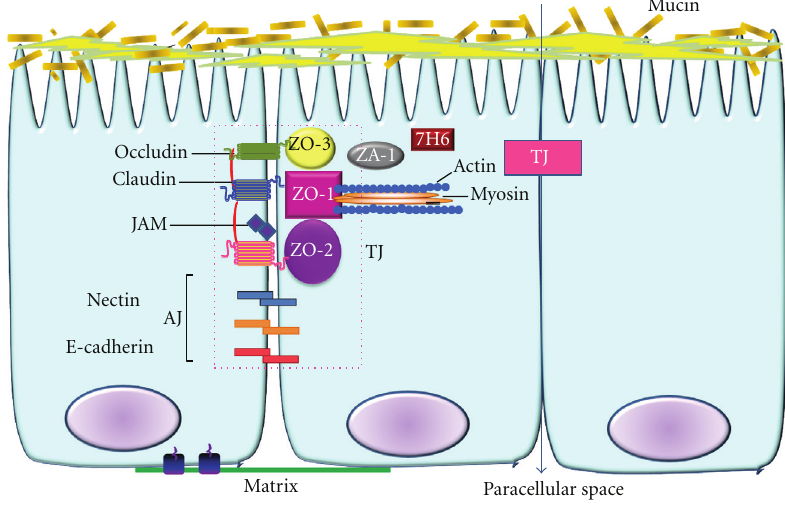
Figure 4: A model of the protein components of tight (TJ) and adherens junctions (AJ) in a highly polarized epithelial cell. The TJ is composed of transmembrane proteins (occludins, claudins, and JAMs) linked to an actin cytoskeleton via cytoplasmic ZO (zonula occludens) proteins. ZO-1 binds to actin. The AJ is composed of the nectin-afadin system and the E-cadherin-catenin system. Nectin’s direct partner, afadin, binds to several proteins, including ZO proteins. Thus TJs and AJs may be closely associated, forming the apical junctional complex, which is linked to the actin cytoskeleton